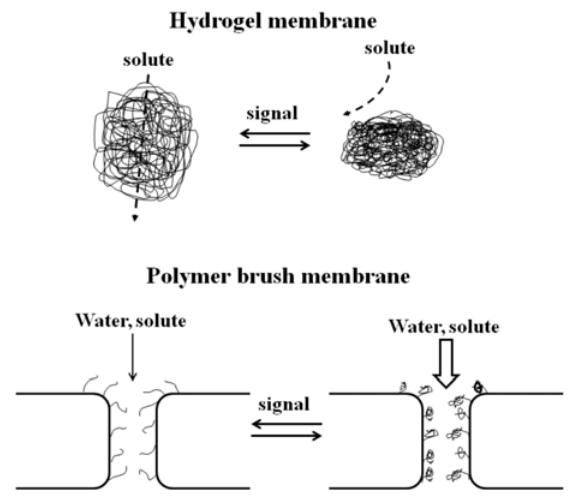
Figure 13. Regulation of water and solute permeation through a hydrogel membrane and a polymer brush-grafted porous